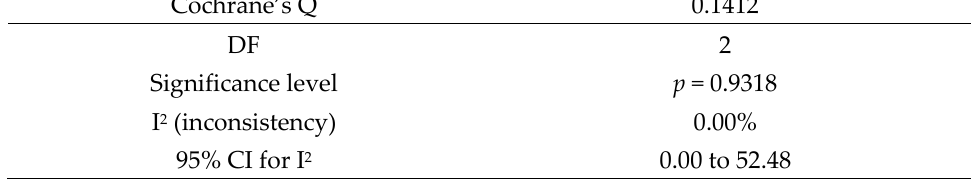
Figure 2. Meta-analysis. Figure 2.